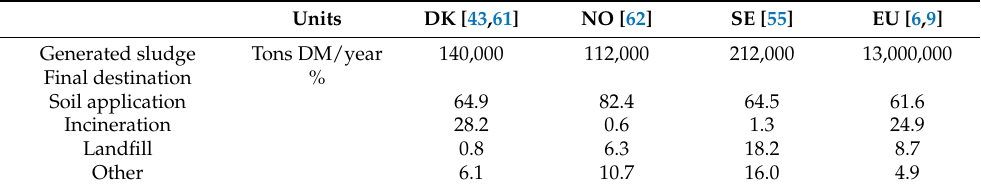
Table 2. Summary of sludge generation and final destination. Soil application comprises its use as fertilizer and plant soil. References are presented in square brackets. DK, Denmark; EU, Europe; NO, Norway; SE,